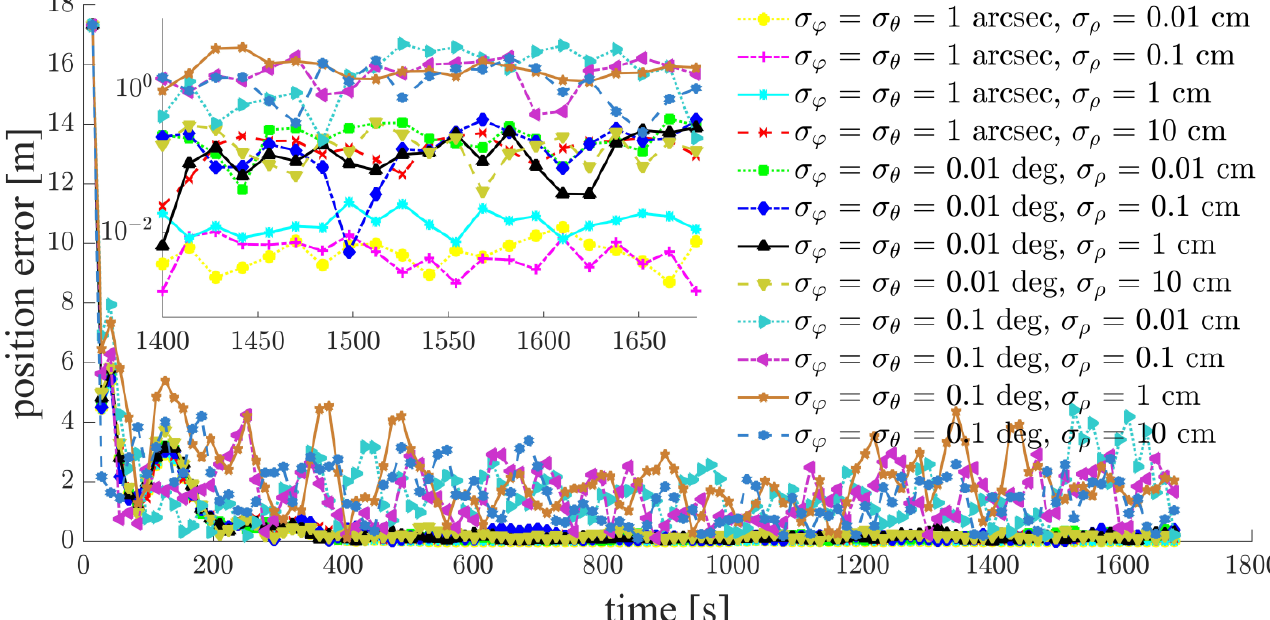
Sensors 2021 , 21 , x FOR PEER REVIEW 17 of 23